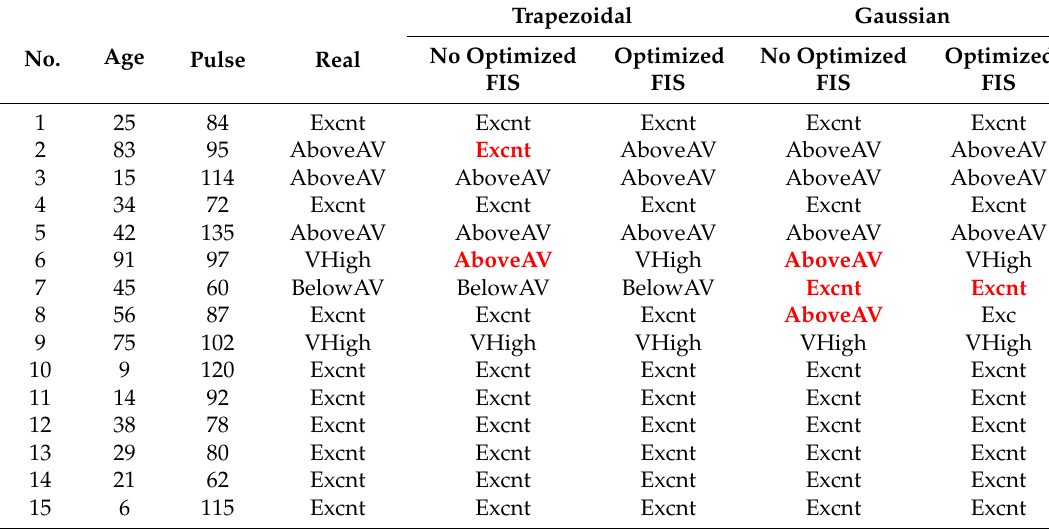
Table 12. Test with random patients.